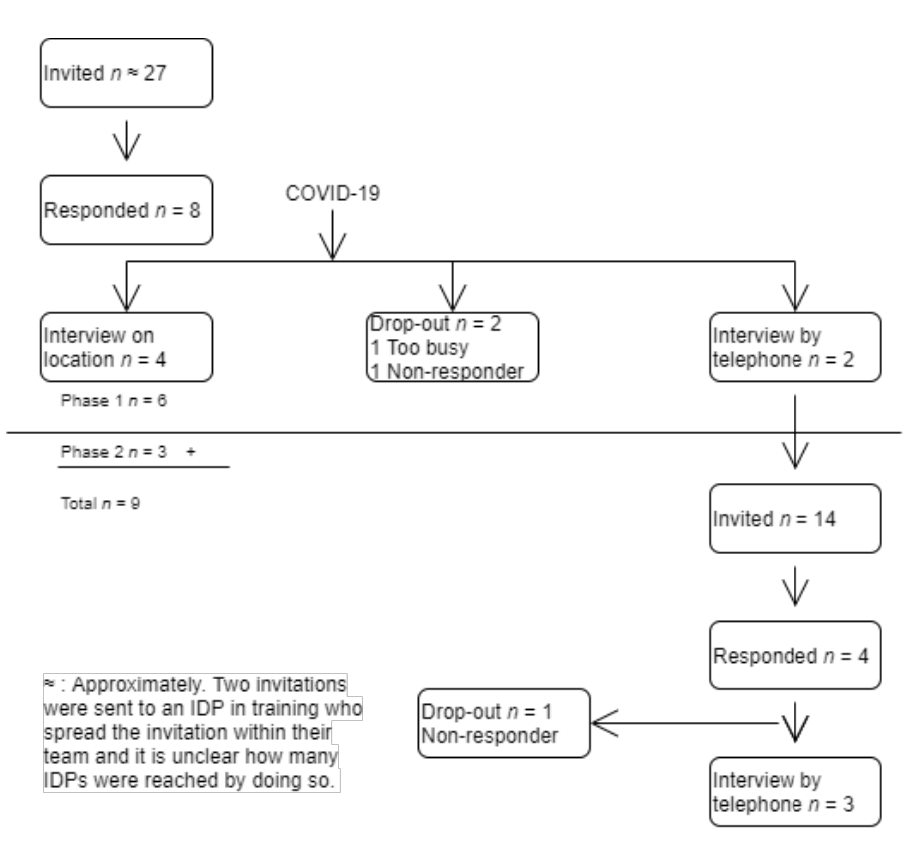
Figure 1. Overview of the recruitment process .